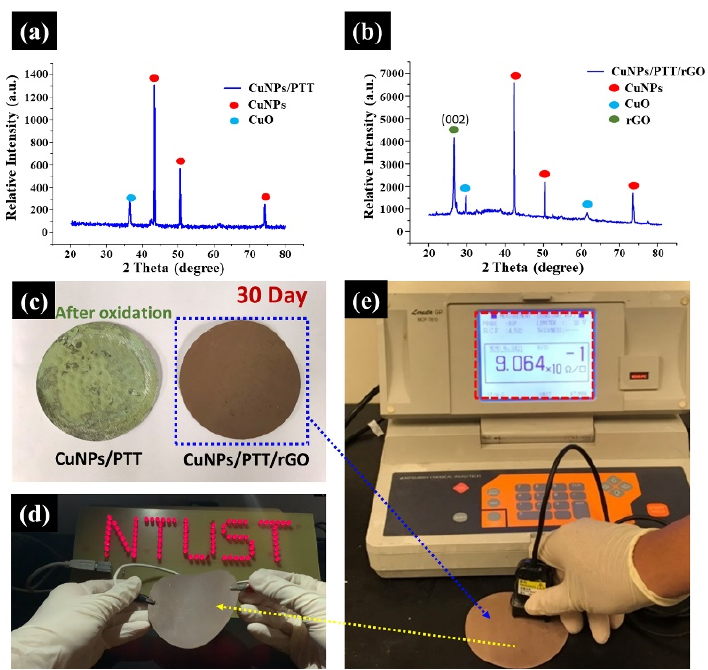
Figure 5. XRD analysis of ( a ) CuNPs/PTT. ( b ) CuNPs/PTT/GO hybrid. ( c ) Digital photos of oxidized CuNPs/PTT and non-oxidized CuNPs/PTT/GO films after 30 days of air exposure. ( d ) The sheet resistance of the CuNPs/PTT/GO film was measured after 30 days of air exposure. ( e ) The LED circuit test of the CuNPs/PTT/GO film demonstrated excellent electrical conductivity.